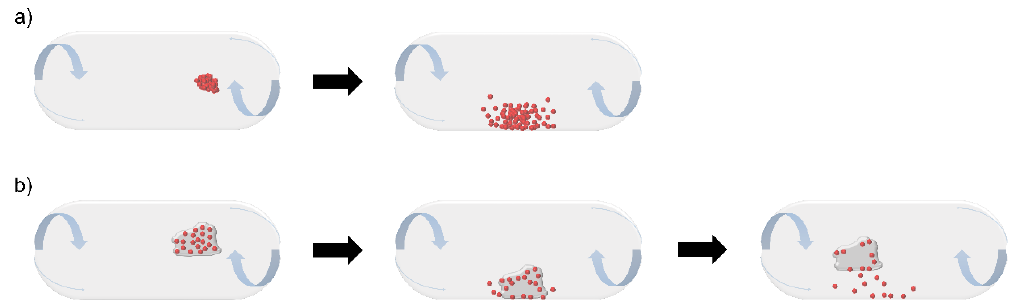
Figure 6. Schematic illustration of de-agglomeration mechanism within the capsule for ( a ) carrier-free agglomerates and ( b ) carrier-based formulation. Table 3. Summary of dry powder-related CMAs and their influence on CQAs and QTPP of cDPIs.